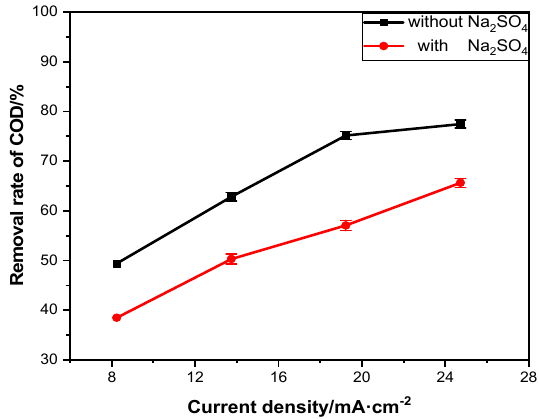
Figure 7. Effect of addition of Na 2 SO 4 on mixed wastewater COD removal rate (anode material: Fe, cathode material: Stainless steel, pH: 7.1, electrolysis time: 70 min).